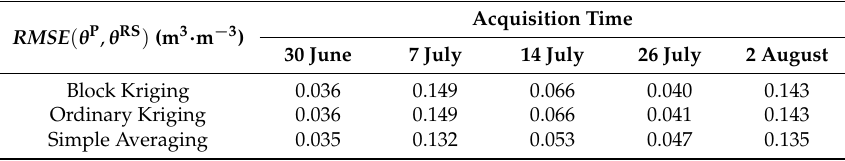
Table 6. Comparison of upscaled soil moisture estimations at plot scale θ P against remote sensing data θ RS using root mean square error